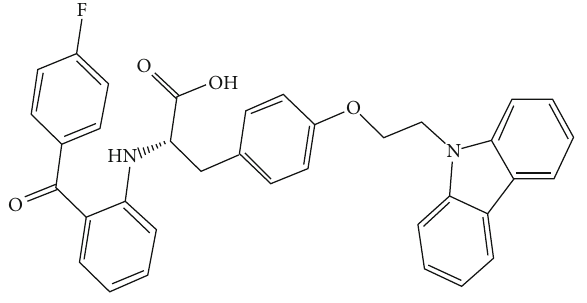
Figure 2: Chemical structure of